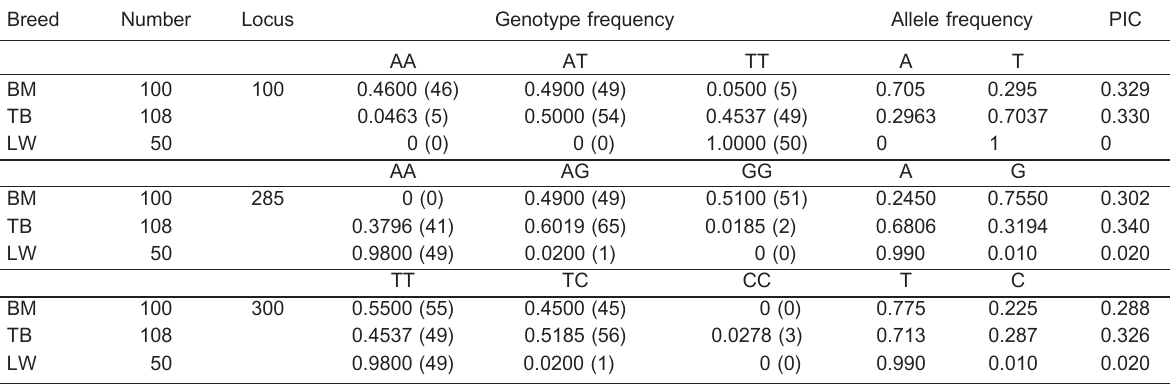
Table 3. Genotype and allele frequency of IGF-1 gene in three pig breeds. Breed